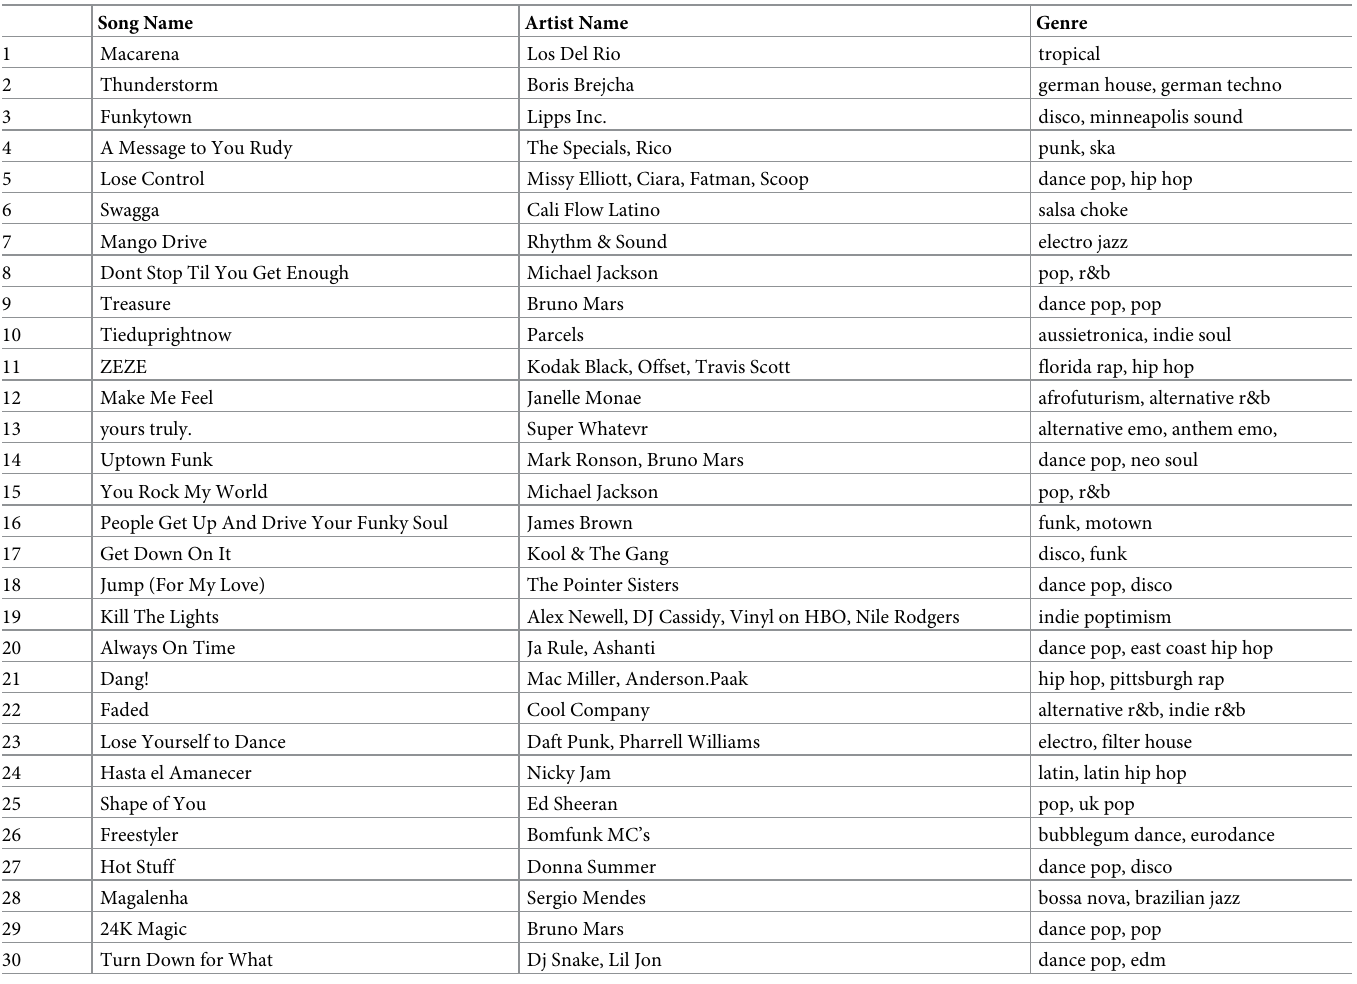
Table 2. 30 songs from the dance music dataset with the highest Spotify danceability